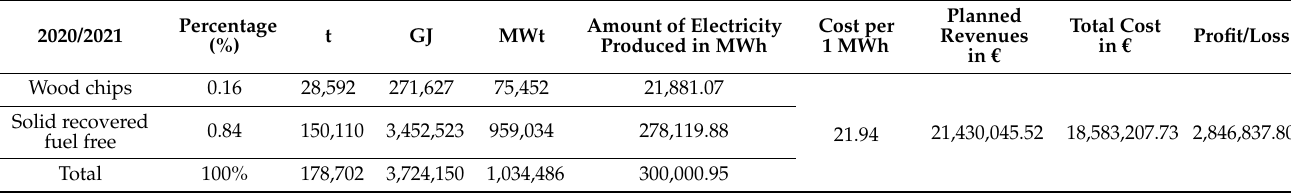
Table 10. Annual conversion of combustion of solid recovered fuel and wood chips in the ratio of